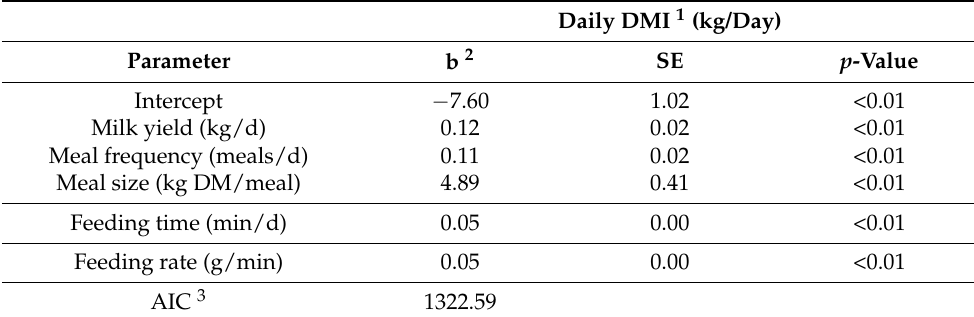
Table 3. Influence of milk yield and intake behavior on dry matter intake during early lactation in dairy cows, estimated by the linear mixed model (LMM) procedure (n = 28).